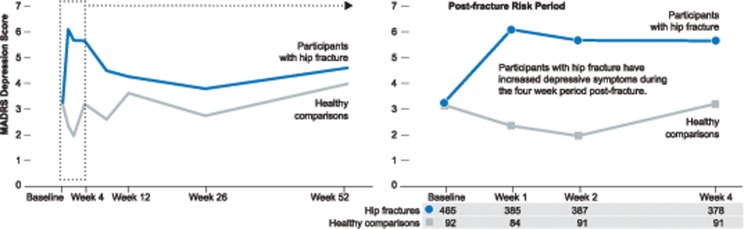
Observed Montgomery-Asberg Depression Rating Scale (MADRS) scores over time for participants with hip fracture and healthy comparisons.The number of participants with hip fracture and healthy comparisons are listed below the figure.